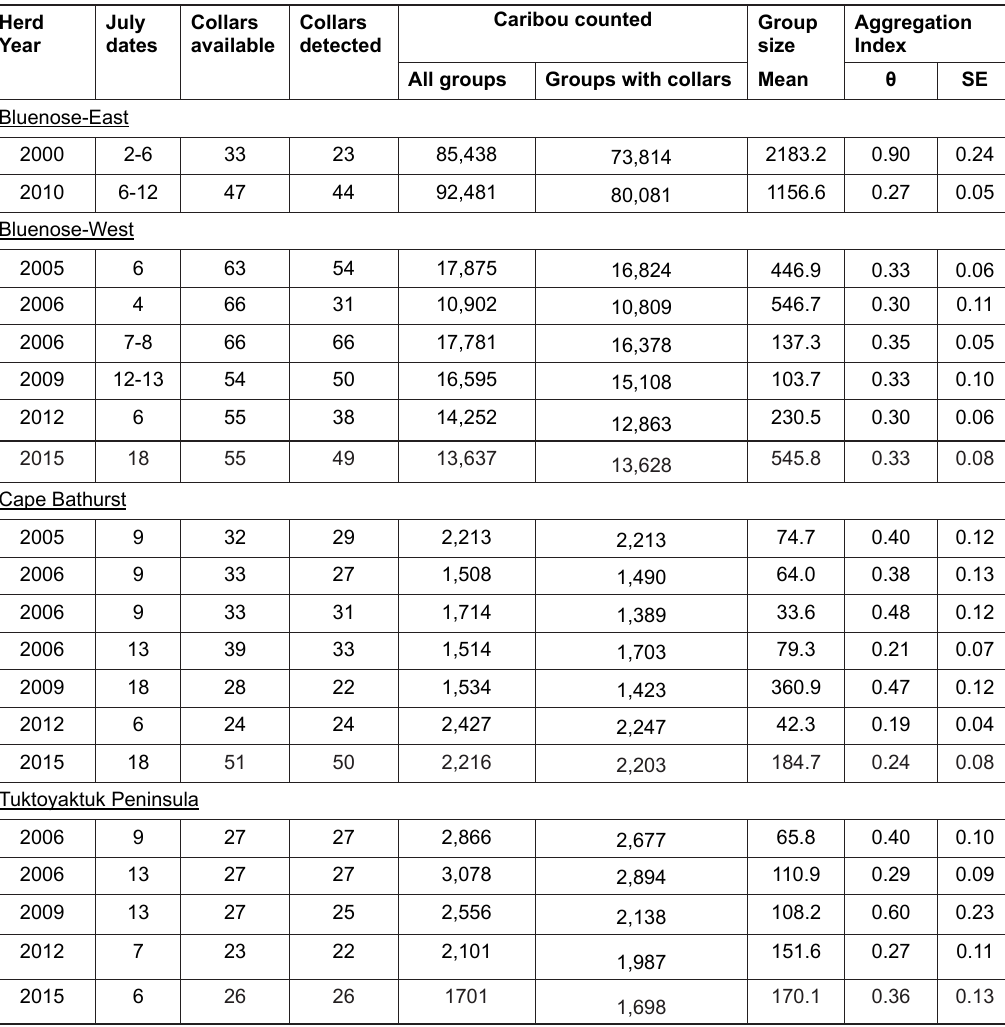
Table 1. Summary of post-calving data sets for caribou herds in the Northwest Territories and Nunavut, Canada, between 2000 and 2015 assessed in this study. Further details on each data set are given in Appendix 1. Herd